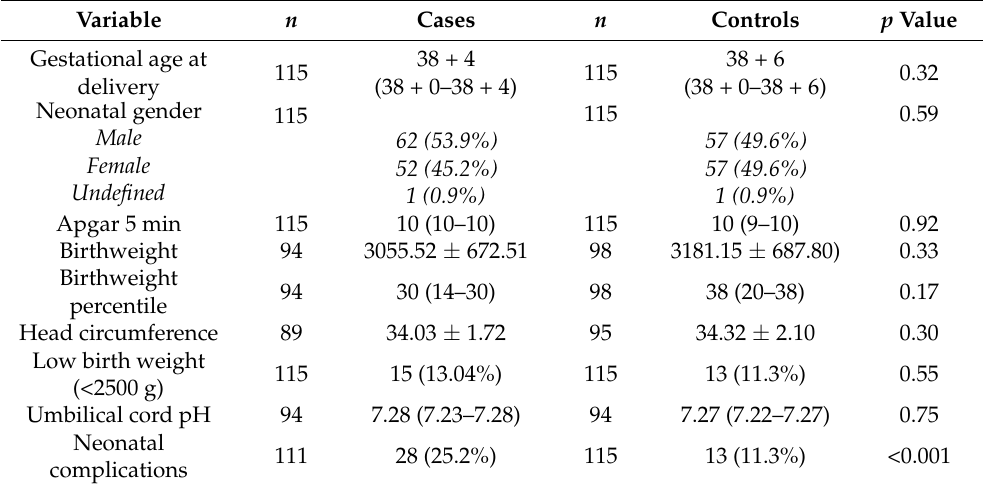
Table 3. Neonatal outcomes of the 230 study participants with and without beta-thalassemia